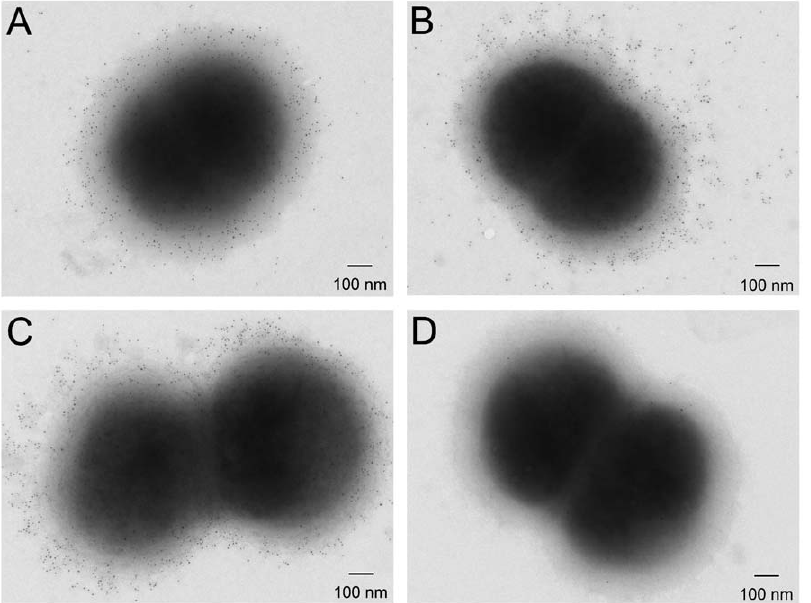
Figure 5. Immuno-electron microscopy of M.catarrhalis . Mice were vaccinated intranasally (1 dose per week, 4 doses in total) with either the adjuvant cholera toxin alone (1 m g/dose/mouse) or the combined conjugates AB (2.5 m g of each carbohydrate per dose per mouse) plus adjuvant. Mouse sera were collected at 1 week after the final immunization. Whole cells of strain 25238 (type A, A), 26397 (type B, B), or 26404 (type C, C) were incubated with the mouse hyperimmune sera (1:400 dilution) followed by gold (5-nm diameter)-conjugated goat anti-mouse IgG. Whole cells of strain 25238 (D) incubated with the corresponding pre-immune mouse sera (1:400 dilution) were included as a control. Scale bar, 100 nm.